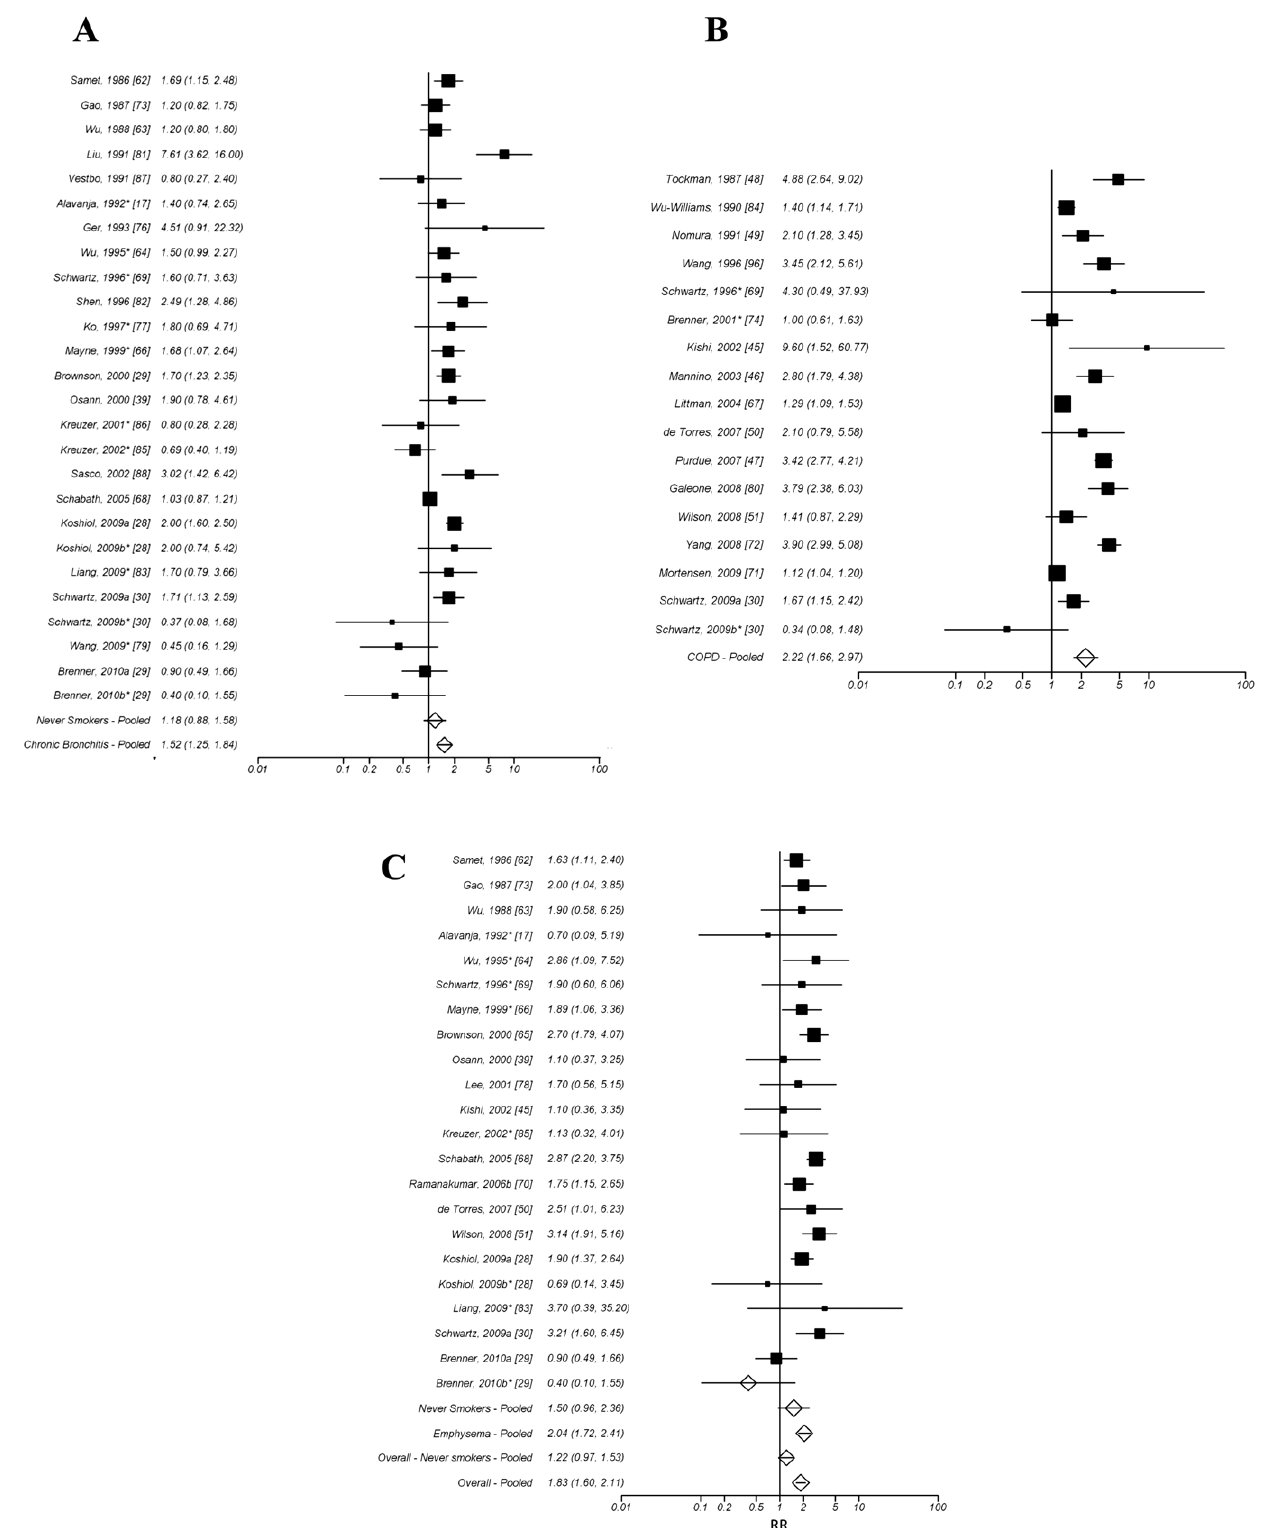
Figure 1. Pooled estimates of the risk associated with a previous diagnosis of COPD, separated by condition and overall with 95% confidence intervals. A - study-specific and pooled estimates for chronic bronchitis. B - study-specific and pooled estimates for COPD. C study- specific and pooled estimates for Emphysema. The estimate labeled Overall – Pooled in panel C represents the combined effects across all three disease groups. RR relative risk. The pooled RRs were estimated from random effects models. *Studies of never smokers. The study labeled Ramanakumar, 2006b [70] represents the estimates for one population in study combined among males and females (no combined estimate originally provided). The studies noted with a b* represent the estimates from a subgroup of never smokers presented in the manuscript which were not included in the overall estimates. doi:10.1371/journal.pone.0017479.g001 PLoS ONE | www.plosone.org